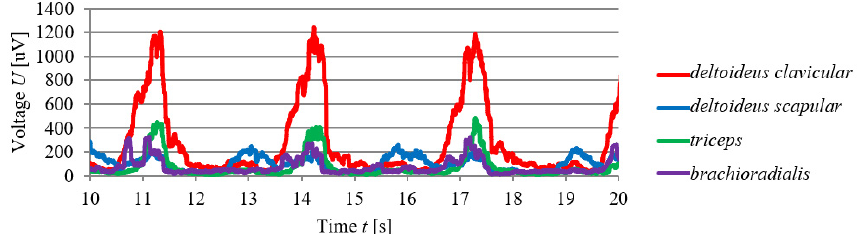
Figure 6. EMG charts for the muscles of the right upper limb for the Wheelchair Cam-thread Drive (WCD).